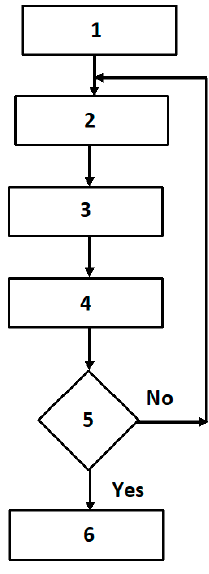
Figure 5. The solution methodology of the developed model. 1 – Initial values input for all flow parameters, 2 – Predictions of all flow parameters (two-fluid model + SMC), 3 – Calculation of T and T b , 4 – Prediction of void fraction, 5 – Convergence, 6 – Stop.